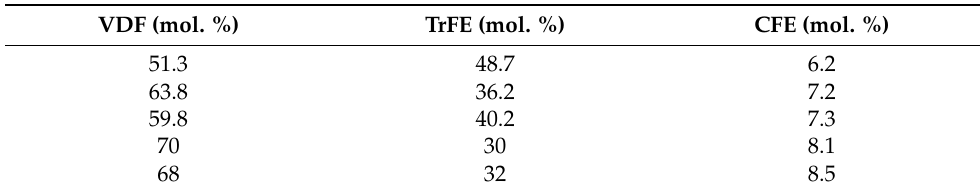
Table 1. The molar content of each component in the studied P(VDFx-TrFE 1-x -CFE y ) compositions. It is important to note that the molar contents are mentioned in a way that the amount of VDF and TrFE adds up to